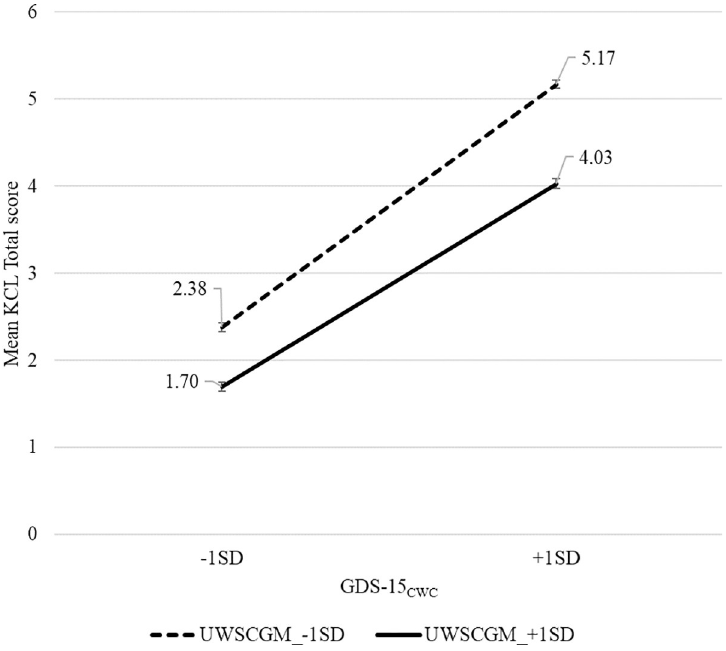
Fig 1. Main-effect analysis of interaction between GDS-15 CWC and UWS CGM . Main-effect analysis, �� p < 0.01. The error bar indicates the standard error (SE). KCL, Kihon checklist; UWS, Usual Walking Speed; GDS-15, Geriatric Depression Scale; CGM, centering at the grand-mean; CWC, centering within cluster; SD, standard deviation.